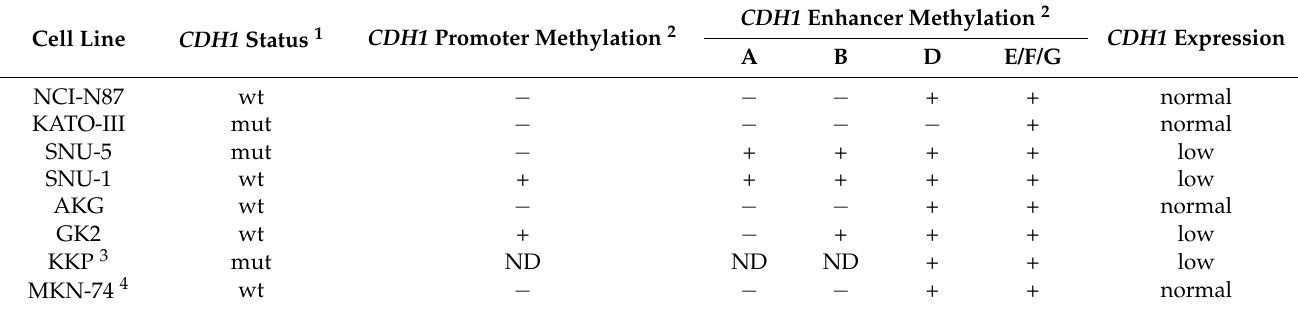
Table 2. Summary of the results obtained on GC cell lines from CDH1 sequencing, methylation and expression analyses. Cell